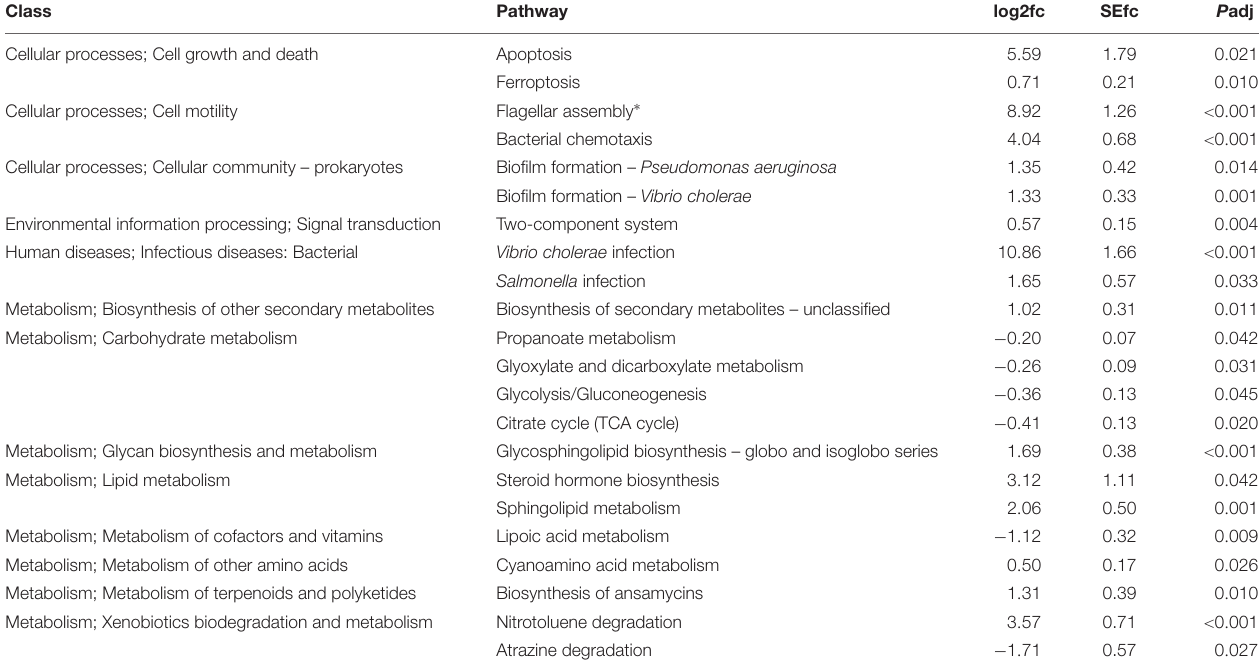
TABLE 3 | Pathway analysis from predicted